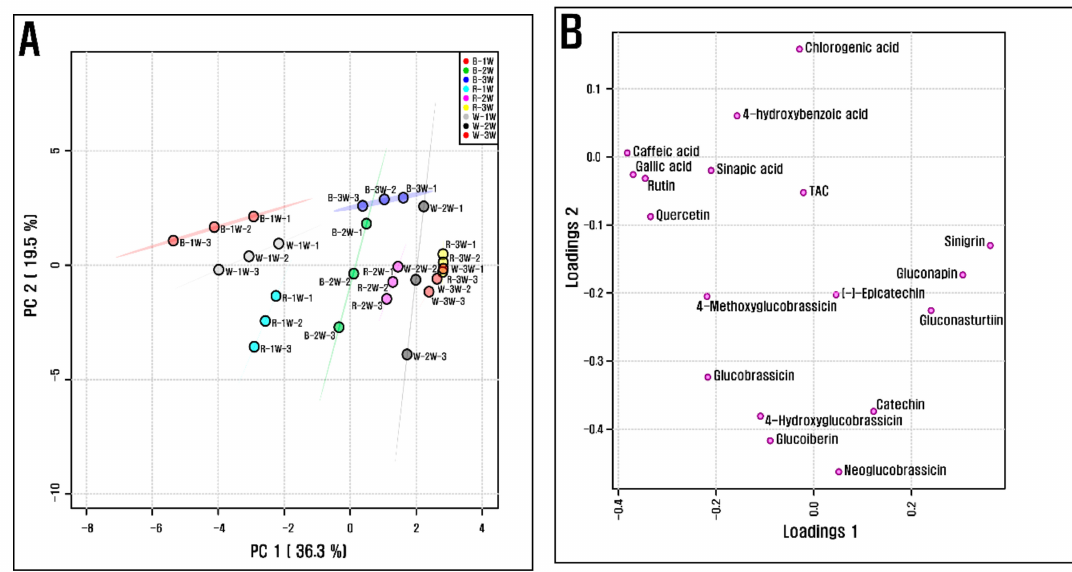
Figure 5. Score plots ( A ) and loading plots ( B ) of the principal component analysis (PCA) results obtained for 18 secondary metabolites from B. juncea sprouts grown under LED illumination of varying